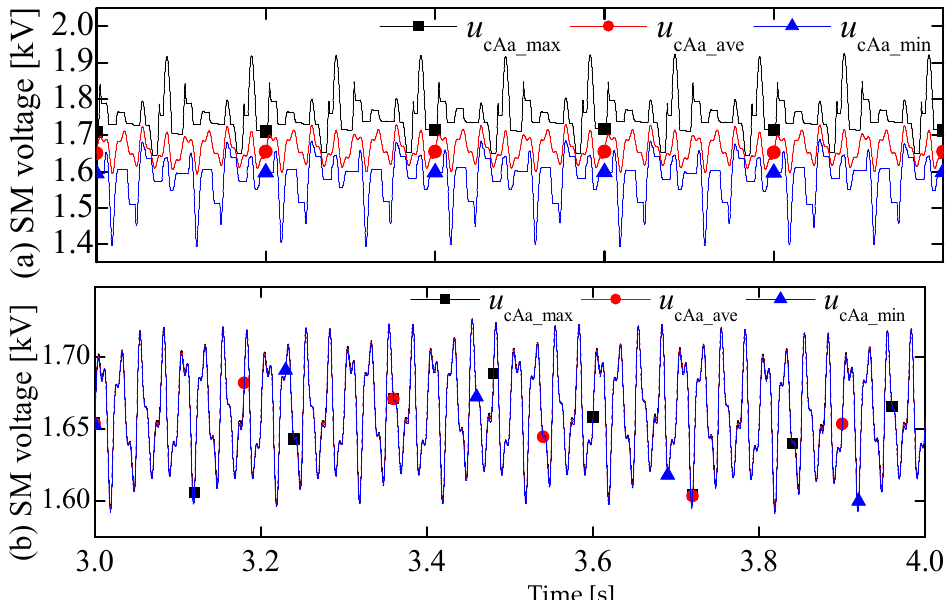
Figure 10. Instantaneous maximum, average, and minimum values of the SM capacitor voltage in arm Aa with di ff erent SM voltage balancing methods: ( a ) reduced switching frequency method; ( b ) conventional method.